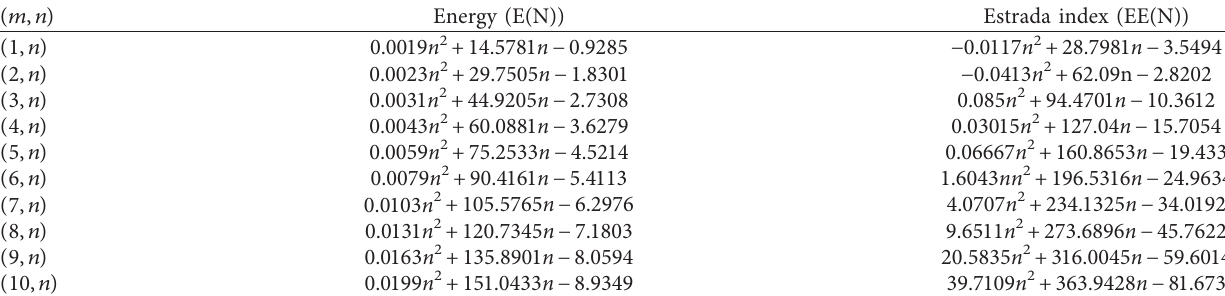
Figure 2: Naphthalene. Table 6: The polynomial of order 2 for the E ( G ) and EE ( N ) of